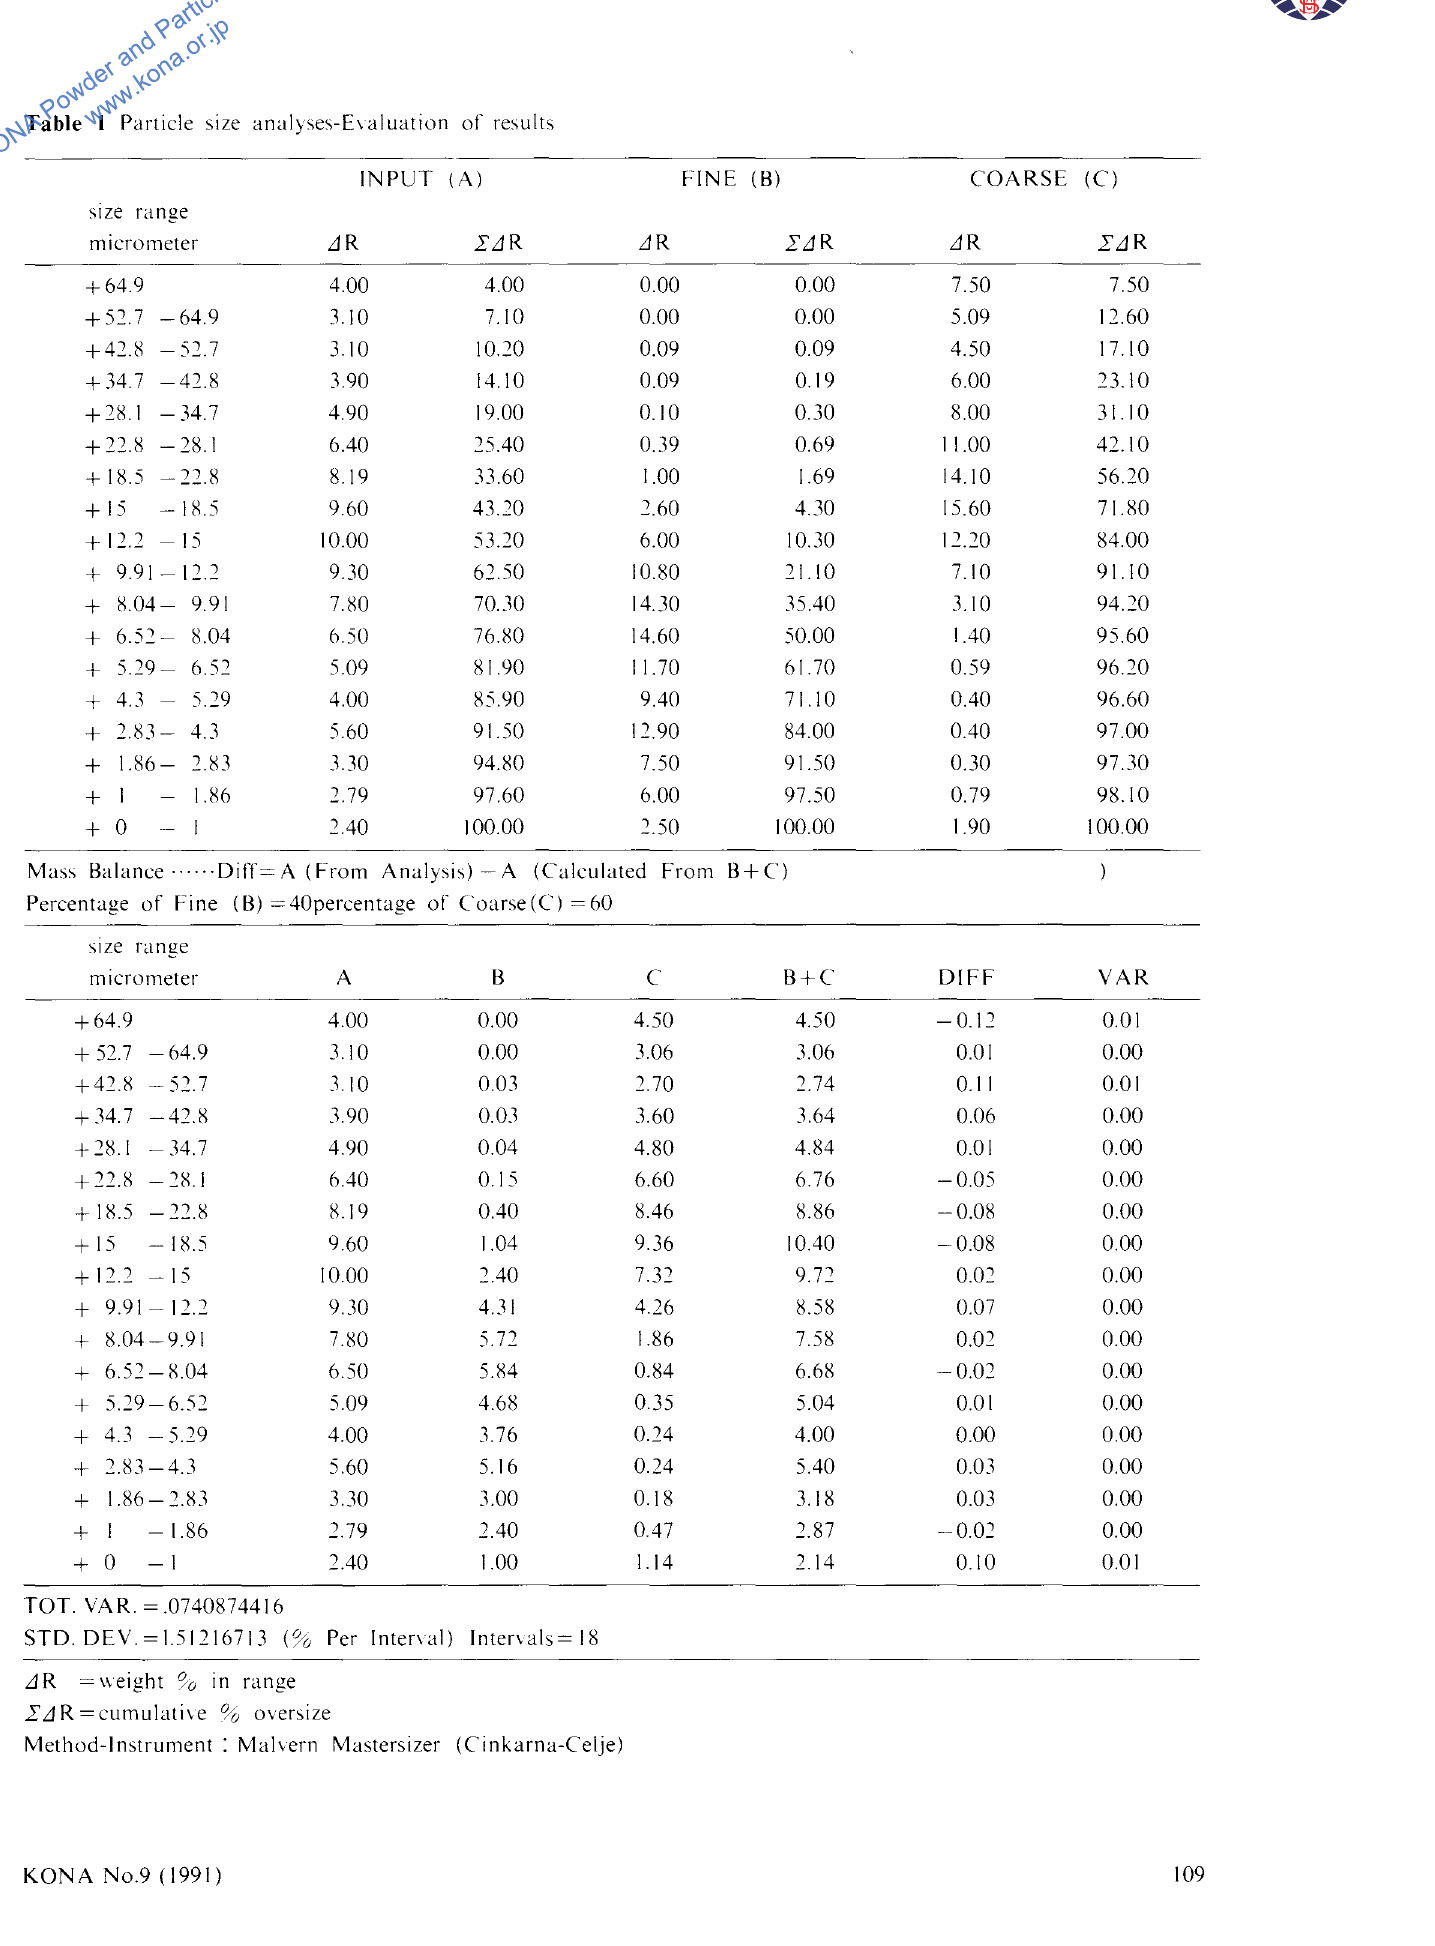
Table I Particle size analyses-E\ aluation of